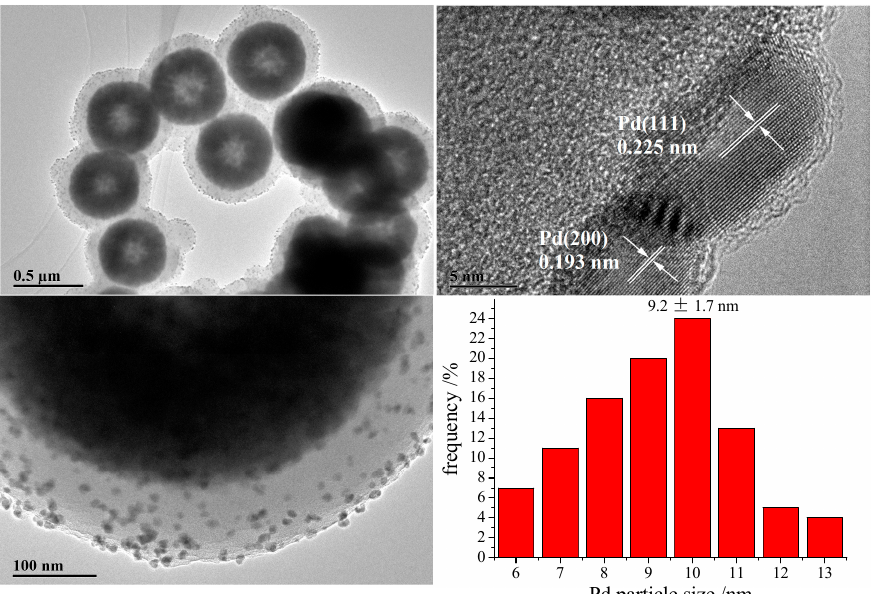
Figure 3. High-resolution transmission electron microscopy (TEM) images of Fe 3 O 4 @PDA@Pd and Pd particle size.